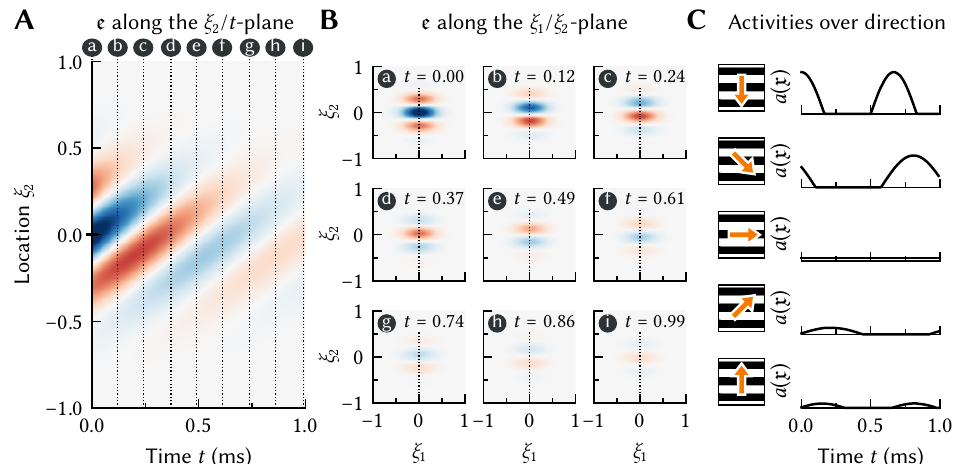
Figure 3. Model of a neuron in visual cortex tuned to downwards motion. The spatiotemporal encoder e is a two-dimensional Gabor filter sampled in two spatial dimensions ξ 1 , ξ 2 that correspond to coordinates in the visual field [25,26]. ( A , B ) Different slices through e . Blue corresponds to positive, red to negative values. ( C ) Computing the neural activity for a grating pattern x moving in the arrow direction. Downwards motion results in the strongest response